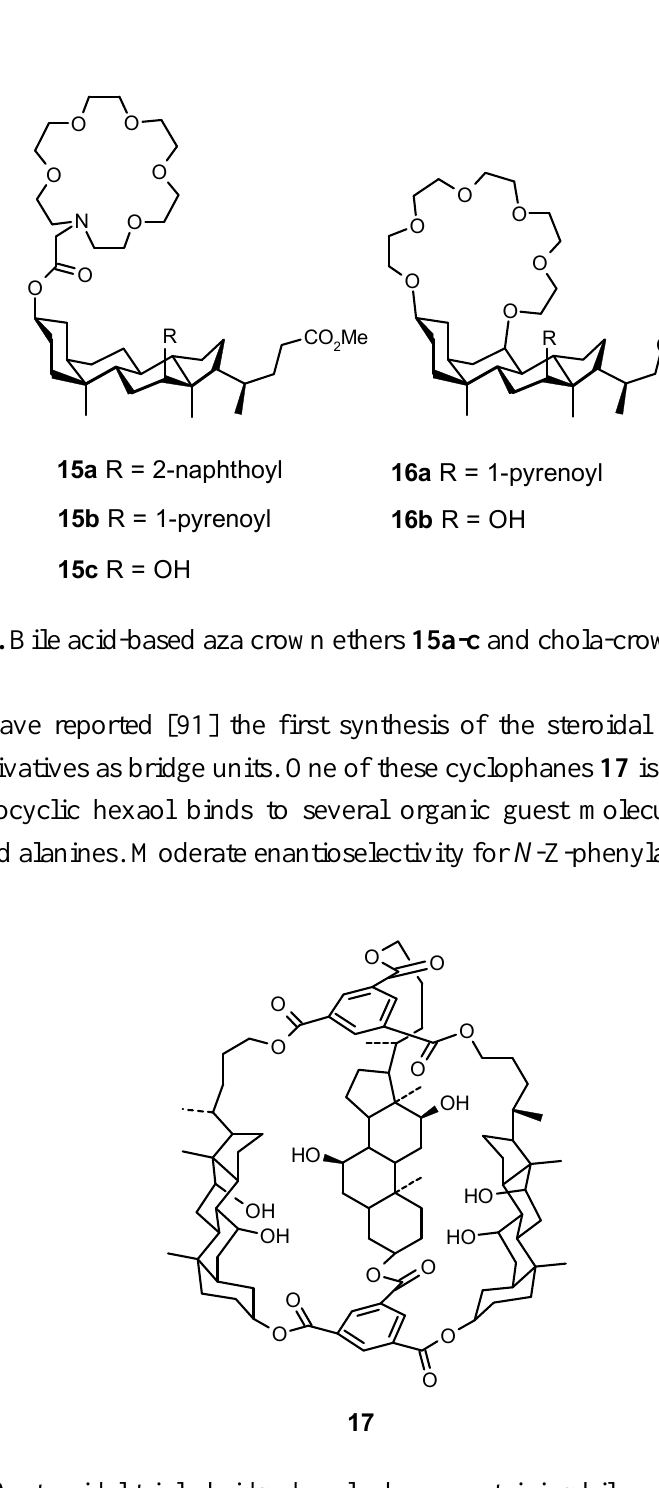
Figure 7. A steroidal triply-bridged cyclophane containing bile acid moieties